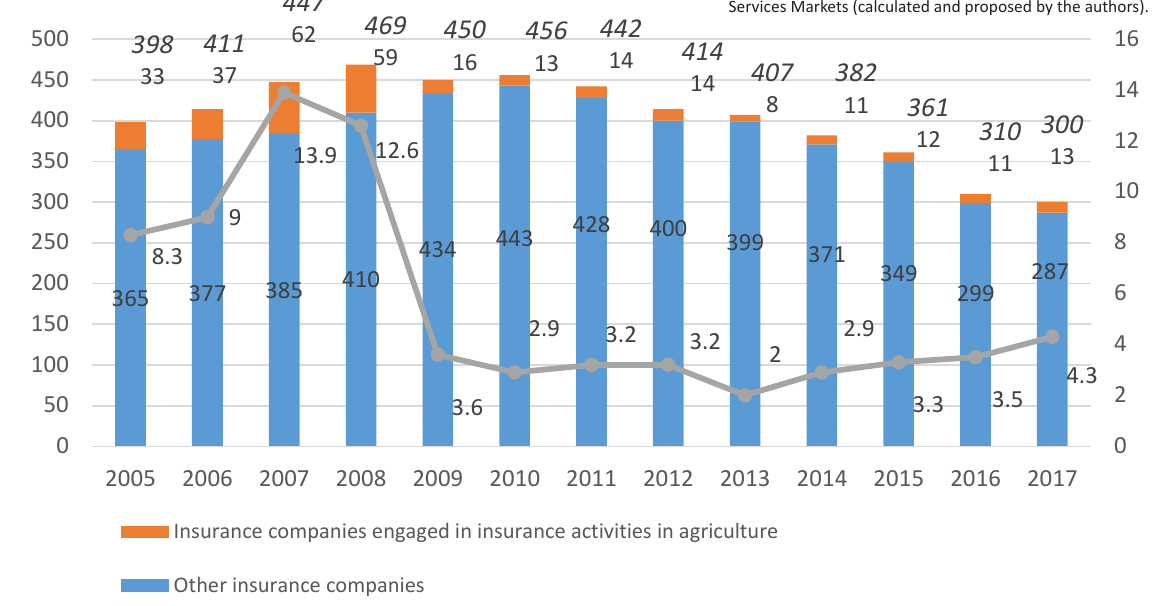
Figure 7. Number (units) and share (%) of insurance companies in the Ukrainian agricultural insurance